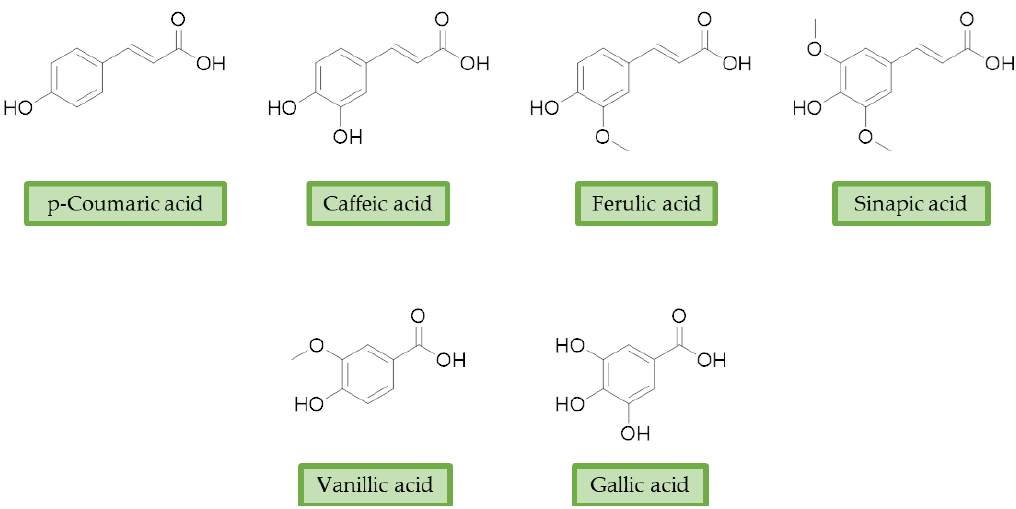
Figure 2. Structures of the main phenolic acids.